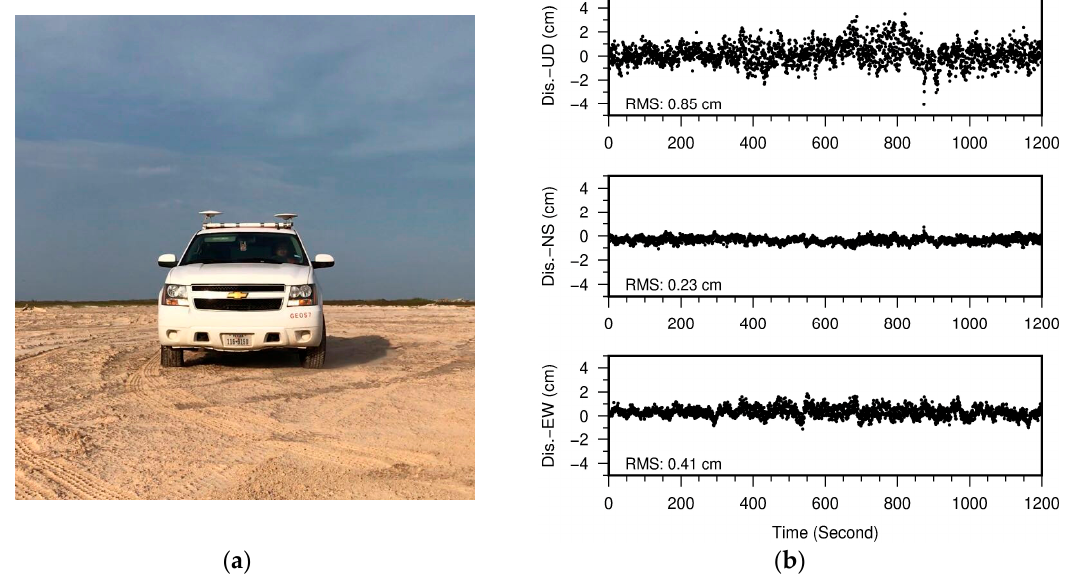
Figure 10. ( a ) Two GPS antennas mounted on the roof of a vehicle for kinematic GPS mapping; ( b ) three-component positional time series of the right antenna during a 20 min period when the vehicle remained stationary on the beach. The sampling rate was one sample per second (1 Hz).